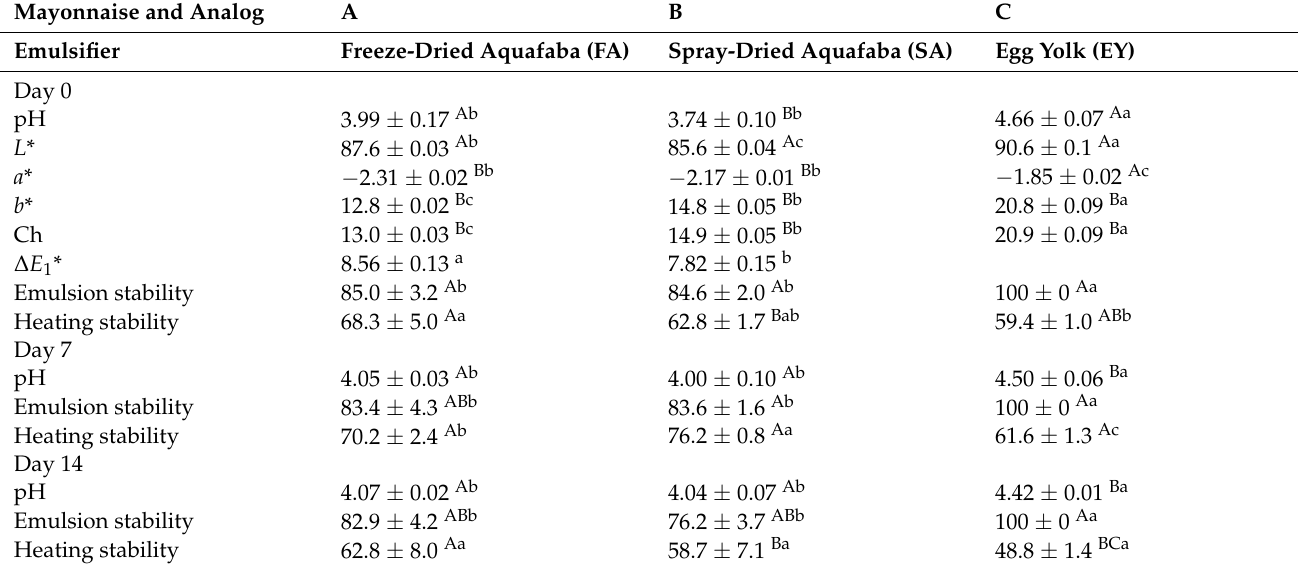
Table 4. Physicochemical properties of mayonnaise and analogs over 28 days of storage at 4 ◦ C. Mayonnaise and